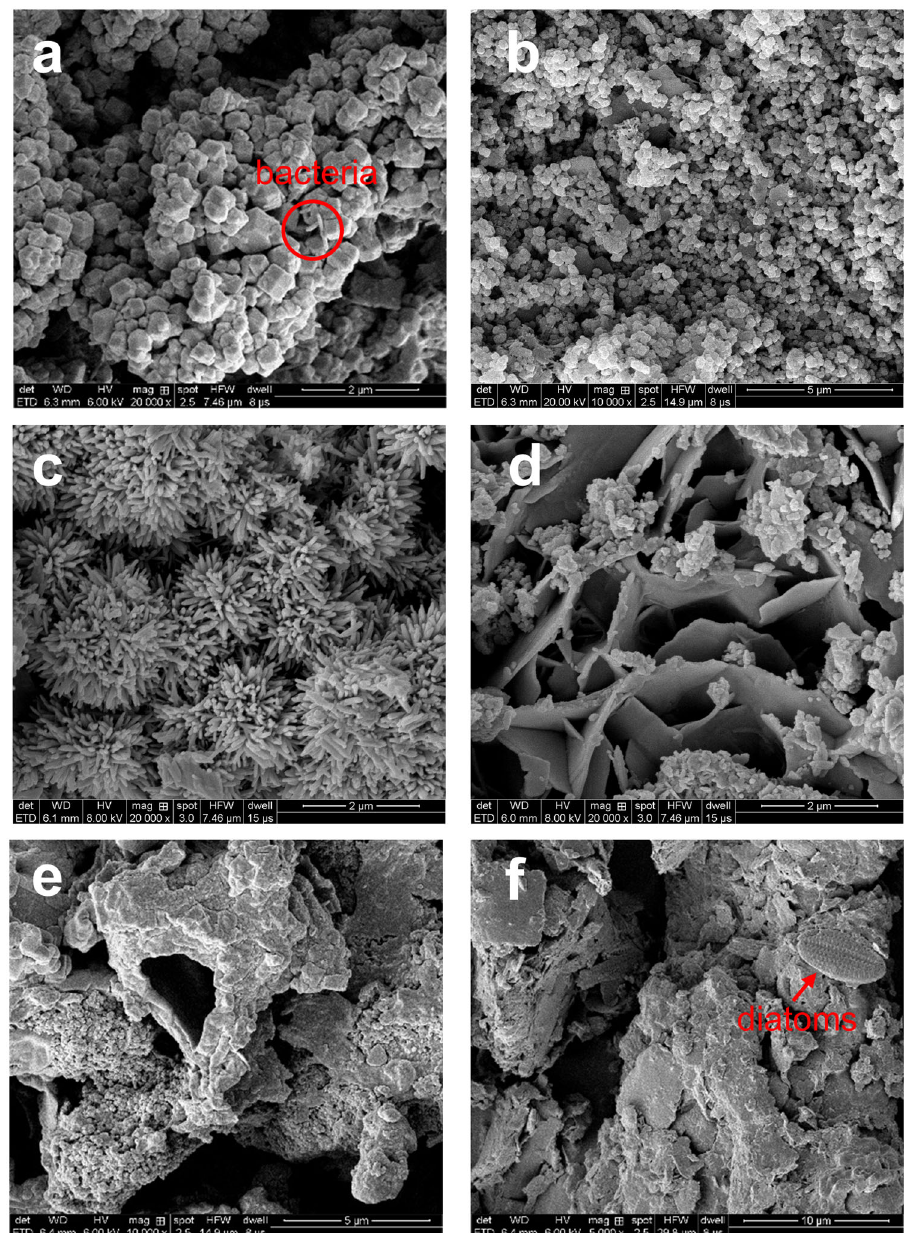
Fig. 2 SEM images of the rust layers of Q345 steel immersed in nature sea water. a , b Inner layer, c , d middle layer, and e , f outer